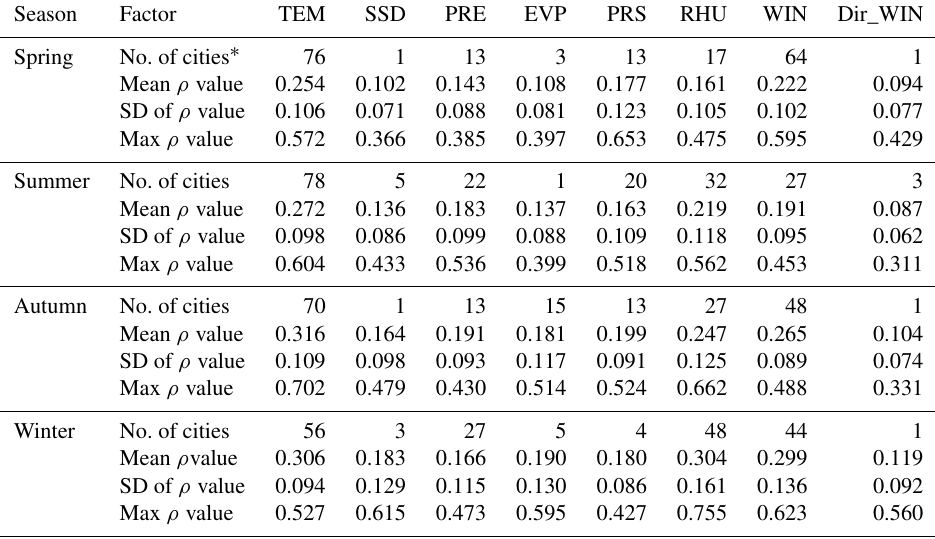
Table 3. The comparison of the influence of individual meteorological factors on PM 2 . 5 concentrations in 188 cities across China (2014–